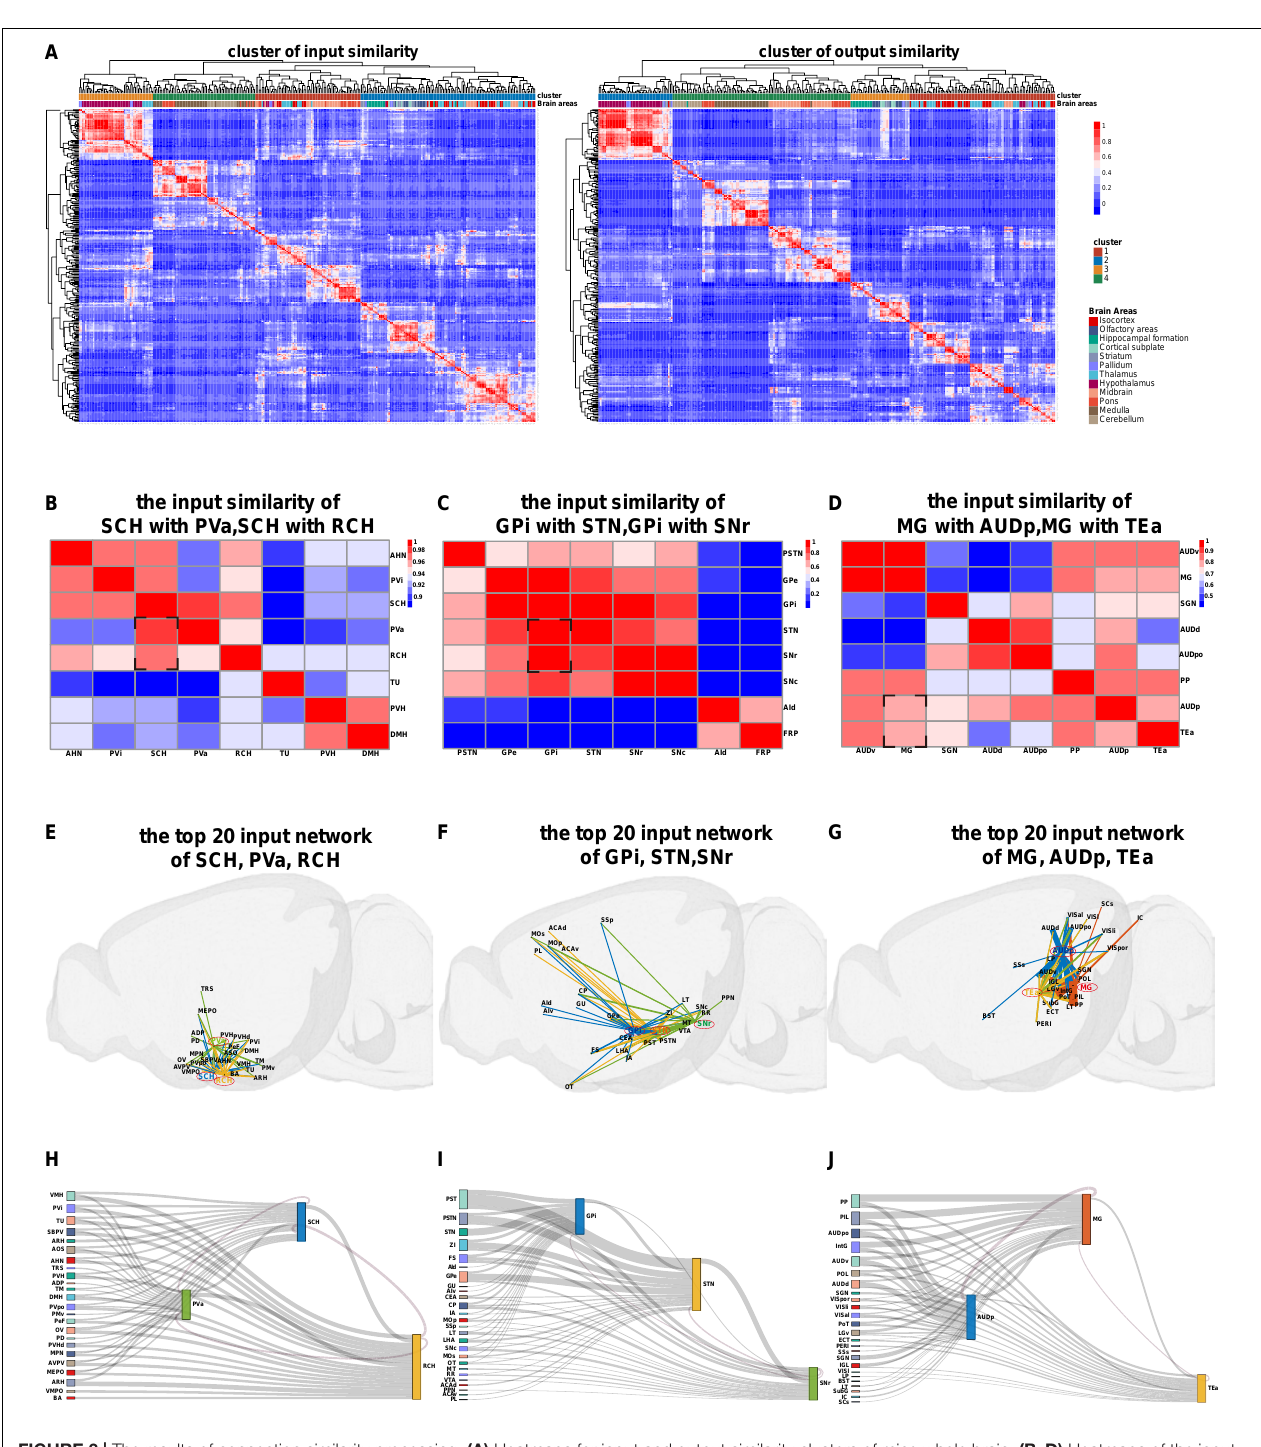
FIGURE 3 | The results of connection similarity processing. (A) Heatmaps for input and output similarity clusters of mice whole brain. (B–D) Heatmaps of the input similarity nuclei. (E–G) The 3D network of input similarity nuclei in panels (B–D) . (H–J) The Sankey diagram of input similarity nuclei in panels (B–D) .